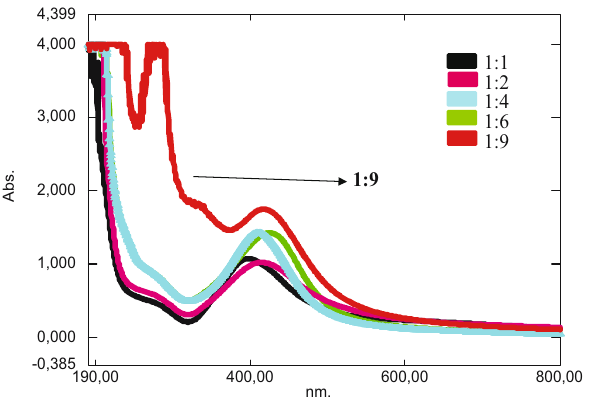
Figure 2: Optimization of silver NPs of pure extracts of T. govanianum .